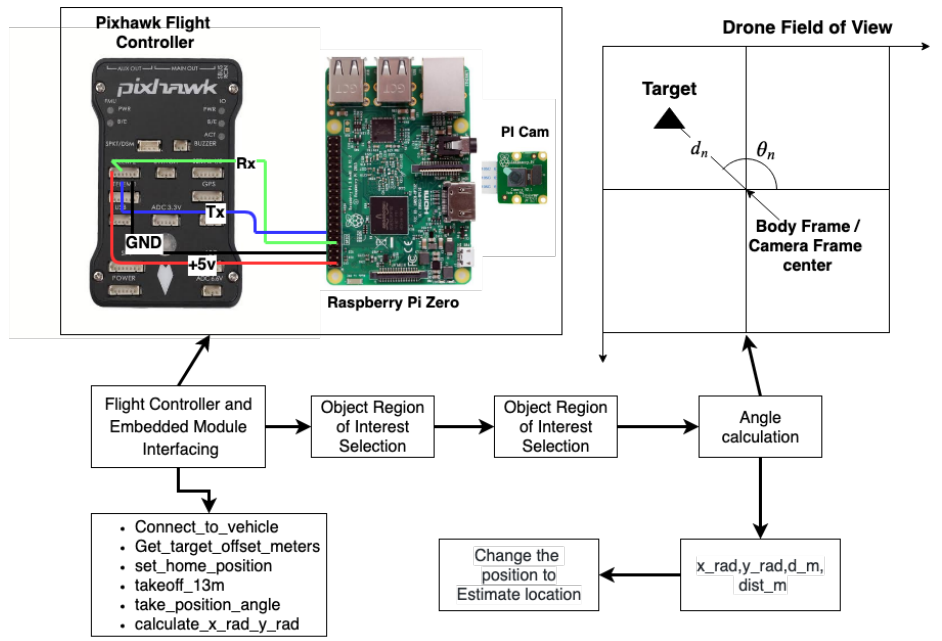
Figure 6. Body frame position estimation.